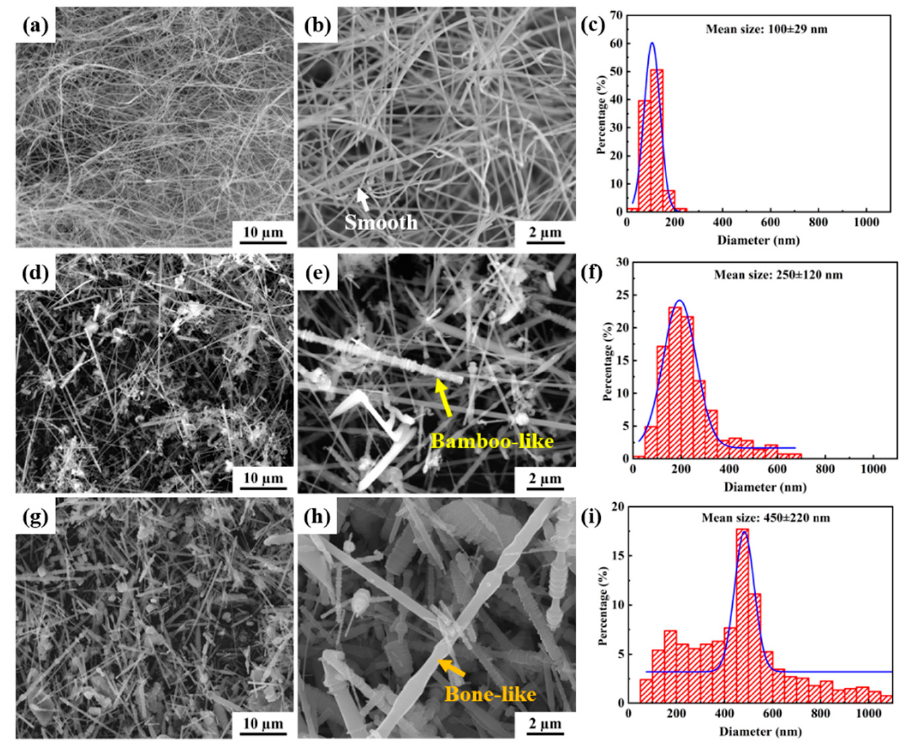
Figure 3. SEM and diameter distribution images of SiCnws. ( a , b , d , e , g , h ) Morphology of 100D, 250D and 450D SiCnws, respectively; ( c , f , i ) Diameter distribution of 100D, 250D and 450D SiCnws, respectively. Three kinds of SiC morphologies were observed. They are cylindrical with uniform diameter and a smooth surface (as shown by the white arrows in Figure 3b), bamboo-like with a rough surface of diameter fluctuation (yellow arrows in Figure 3e) and bone-like with a smooth surface of diameter fluctuation (orange arrows in Figure 3h). The surface roughness is related to the size of the nanowires; the larger the surface, the rougher it is. The surface of 100D is smoother, while the surfaces of 250D and 450D nanowires have more protrusions, which are bamboo-like and bone-like. Although nanowires have different morphologies, studies have shown that they all have the effect of inducing stacking faults [38]. It is worth noting that the proportion of each morphology is different. Figure 4 shows the statistics of the three morphologies in SiC nanowires with different diameters. In the nanowires with an average diameter of 100 nm, the proportion of cylindrical, bamboo and bone rod are 97.4%, 0.8% and 1.8%; the ratio of three morphologies of 250 nm is 22.4%, 45.5% and 32.1%; the morphology of 450 nm nanowires accounted for 15.1%, 30.1% and 54.8%, respectively. It is worth noting that there is a certain correlation between the morphology and diameter of SiCnws. When the diameter is small, it exhibits a smooth cylindrical surface, and when the nanowire diameter is large, it is easier to exhibit bamboo- like and bone-like surfaces